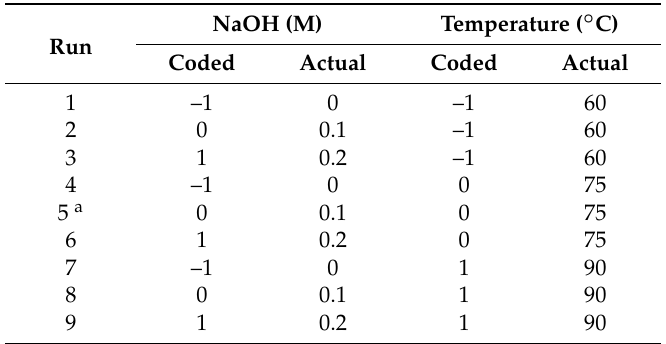
Table 2. Experimental design for response surface